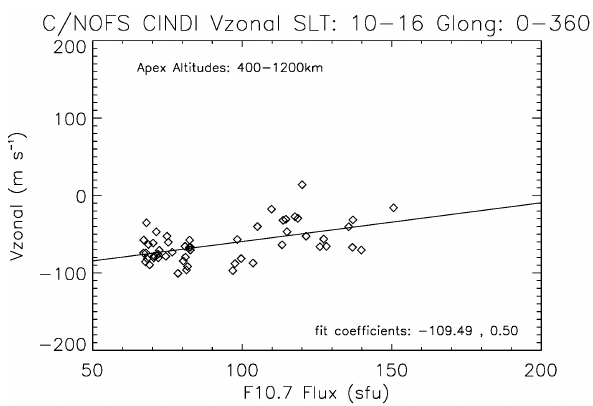
468 Figure 10. CINDI zonal ion drift versus SLT in the 260 ° –270 ° longitude range and 469 the 400–100 km apex altitude range for each of the four years from 2009 to 2012. 470 Fig. 10. CINDI zonal ion drift versus SLT in the 260–270 ◦ longi- The 24 hour averaged zonal velocity is indicated for each year. 471 tude range and the 400–100km apex altitude range for each of the 472 473 4yr from 2009 to 2012. The 24h averaged zonal velocity is indi- cated for each year.